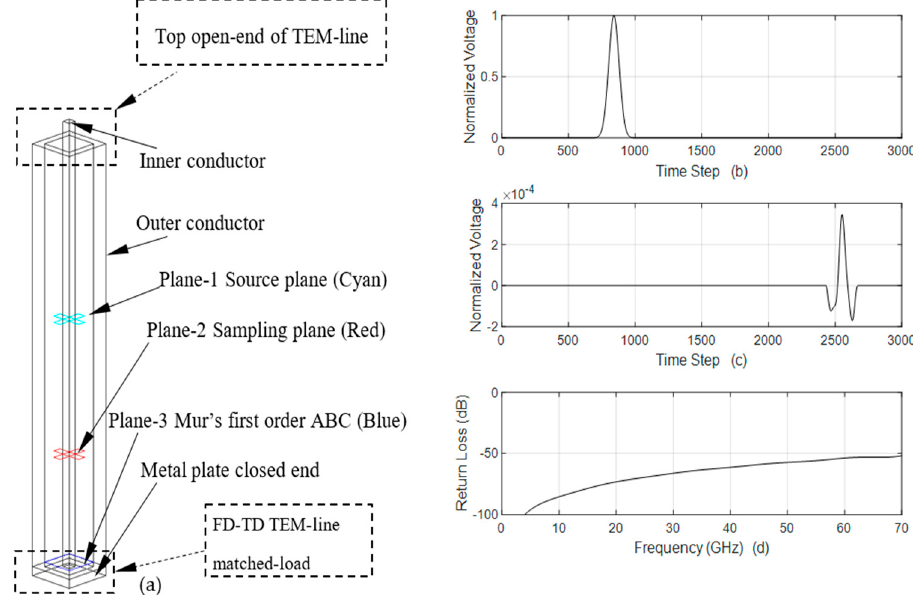
Figure 2. ( a ) A 3D isometric view of the TEM feed-line; ( b ) An example of normalized incident Gaussian pulse launched from Plane-1 and collected at Plane-2; ( c ) The reflected wave from the FD-TD numerical matched-load (normalized to the maximum value in ( b )) and collected at Plane-2; ( d ) The return loss of the FD-TD numerical matched-load (see the text for more details).